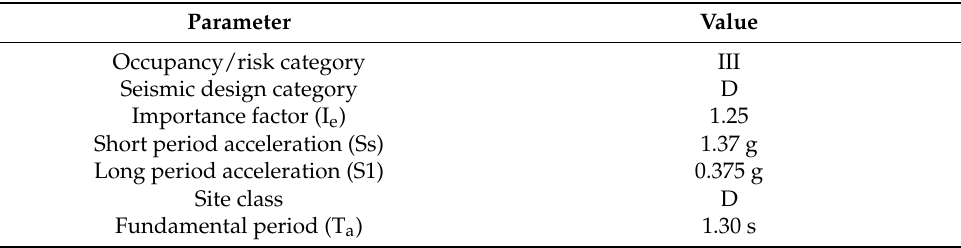
Table 2. Seismic assessment parameters.